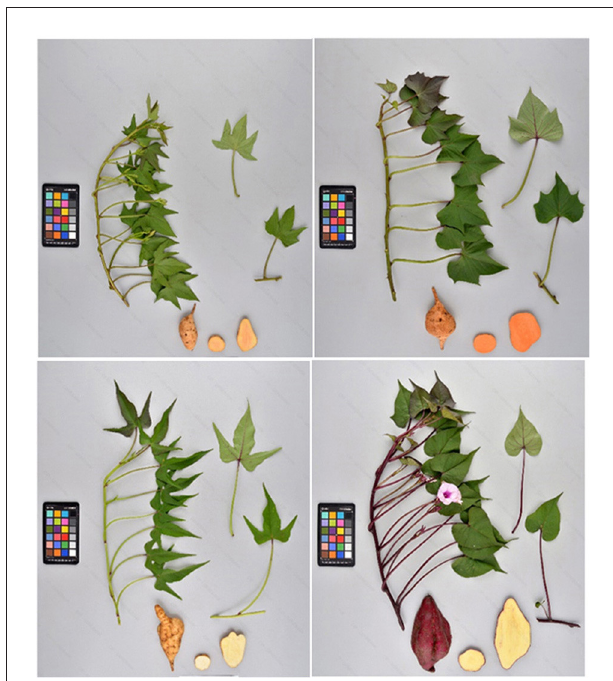
FIGURE 4 | Examples of in vitro and mother plants with different phenotypes and genotypes of the same accession. Storage roots and leaves from greenhouse mother plants and in vitro derived plants from two accessions not true to type (nTTT) as observed by different phenotypes indicating a genetic mixture and storage roots. Upper left: CIP 420081 original source plant. Upper right: CIP 420081 in vitro derived plant. Lower left: CIP 420101 original source plant. Lower right: CIP 420101 in vitro -derived plant.